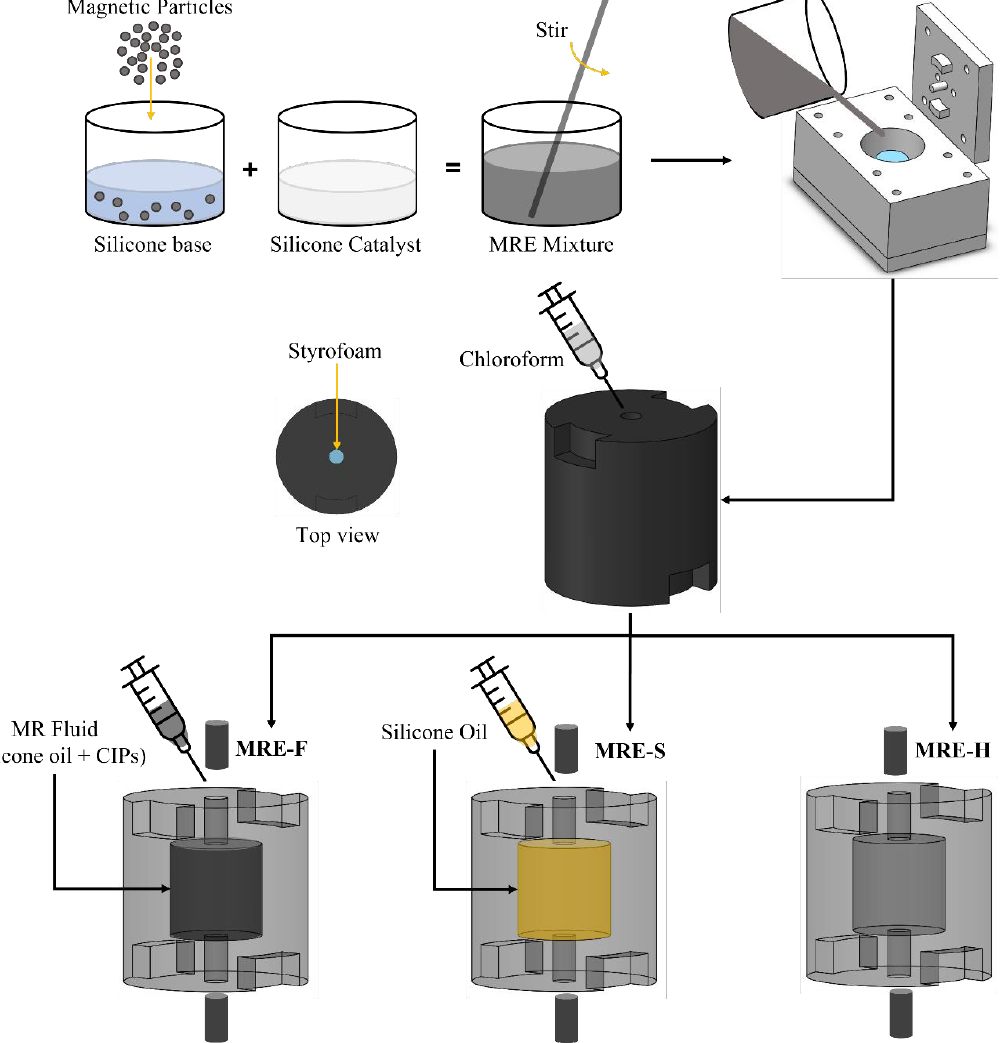
Figure 4. Schematic of the fabrication of the hybrid MRE materials.